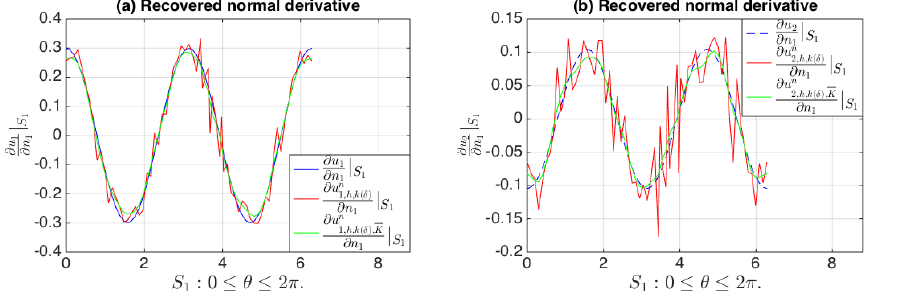
Figure 5. ( a ) Plots of exact normal derivative of u 1 and its approximations with and without sequential smoothing corresponding to input data with error V δ , using mesh M 1 of circular region. ( b ) Plots of exact normal derivative of u 2 and its approximations with and without sequential smoothing corresponding to input data with error V δ , using mesh M 1 of circular